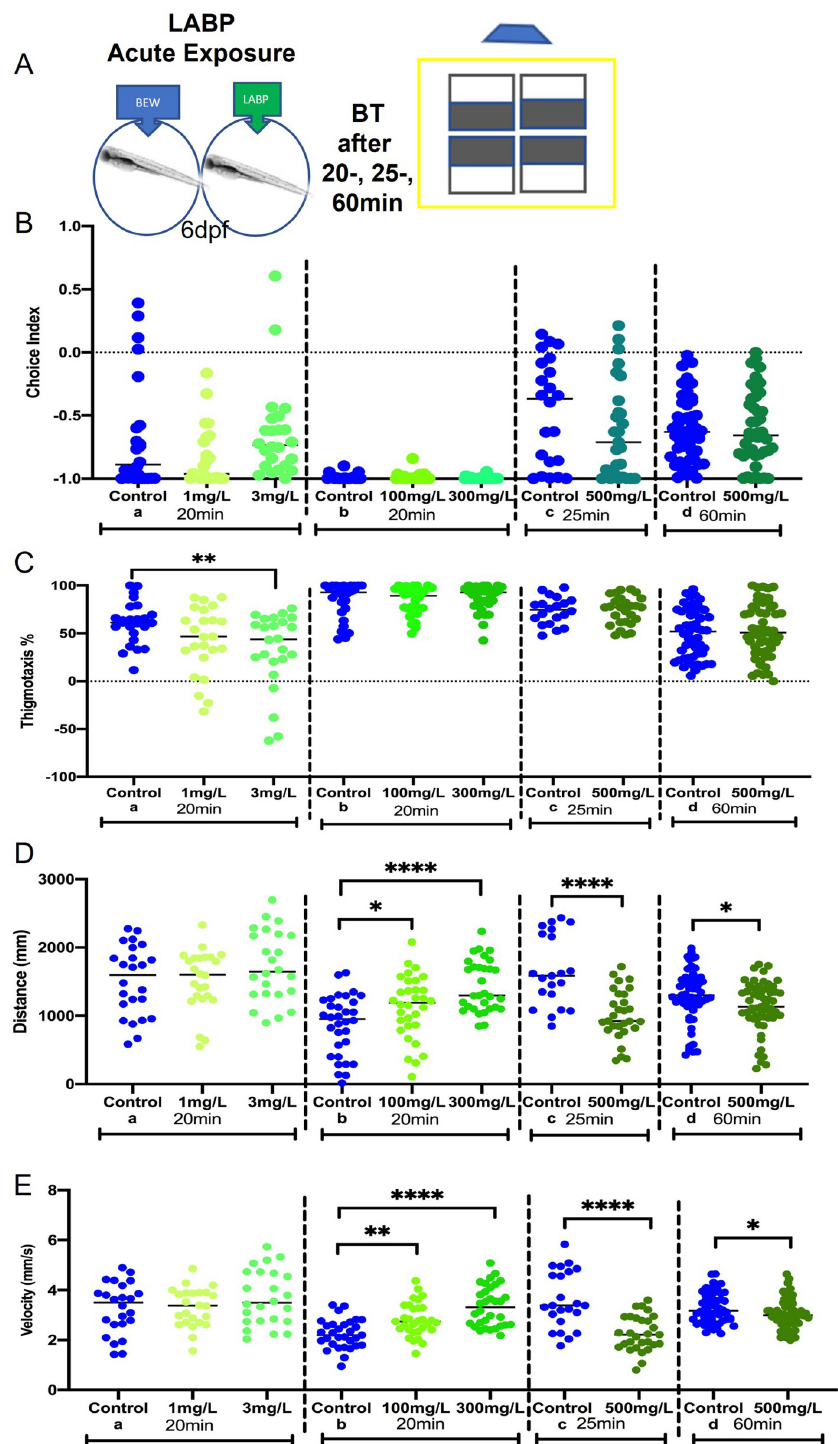
Fig 2. Behavior effects after LABP acute exposure. A. The schematic of the behavioral testing after LABP exposure (20, 25, or 60 min) in different concentrations (1, 3, 100, 300, or 500 mg/L). B. There was no significant difference in choice index between the control group and LABP treated groups. C. After 20 min of 3 mg/L LBP exposure decreased thigmotaxis significantly (p = 0.0082). The other groups did not show significant differences when compared to control. D. 100 and 300 mg/L LABP added 20 min before testing increased distance significantly (p = 0.0297 and